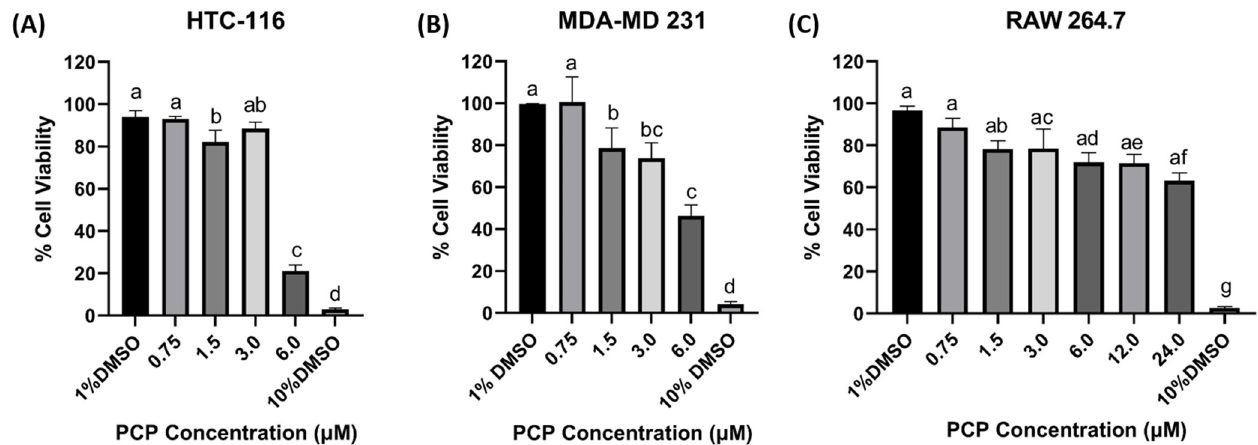
Figure 5. Anti-tumour potential of purified PCP on human colorectal (HTC-116) ( A ), human metastatic breast adenocar- cinoma (MDA-MD 231) ( B ), and abelson murine leukaemia virus-induced tumour macrophage (RAW 264.7) ( C ) cancer cell lines. Results represent the mean ± SD of three replicates compared to positive control (1% DMSO) and kill control (10% DMSO). Different superscript letters on column bars denotes significant difference at p < 0.05.